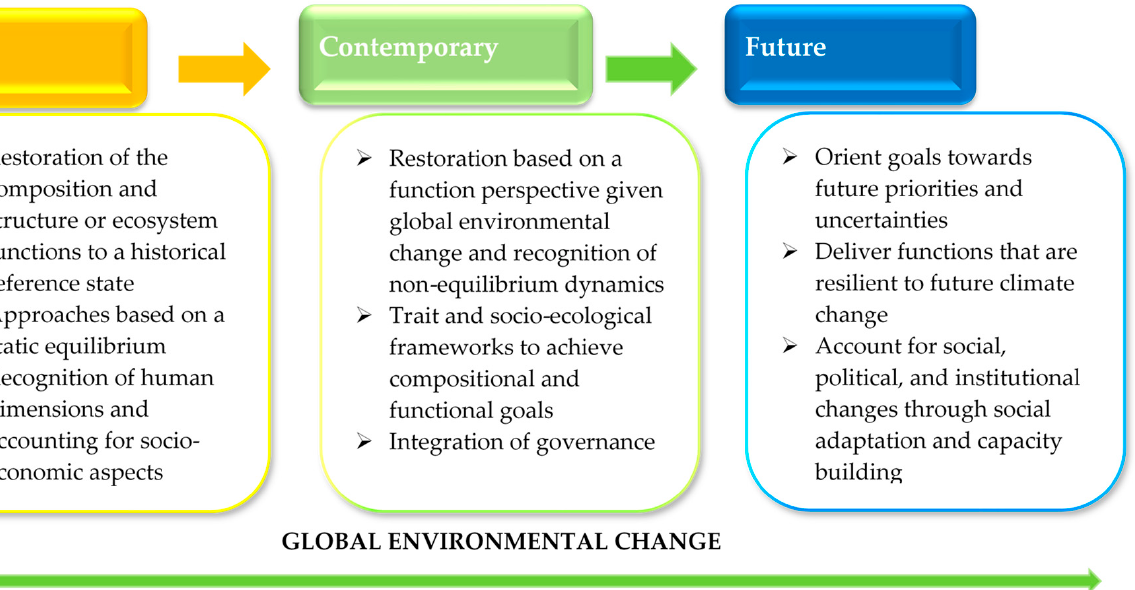
Figure 1. Framing FLR under global environmental changes. Traditionally, FLR has focused on restoring species composition and structure that would lead to desired functions (e.g., ecosystem services) with an ecological view of the equilibrium in an unchanging environment, while accounting for human dimensions to provide socioeconomic benefits for communities. Due to growing recognition of non-equilibrium dynamics and persistent global environmental changes over time, contemporary FLR uses trait and socioecological system (SES) frameworks in combination with governance to achieve dynamic and process-based restoration goals. In an era of socioenvironmental change and uncertainty, sustainable FLR should increasingly aim to deliver functions that are resilient to future climate change based on a new understanding of ecological processes and to take greater account of the human dimensions in terms of social adaptations and capacity building. Source: Modified from [19].